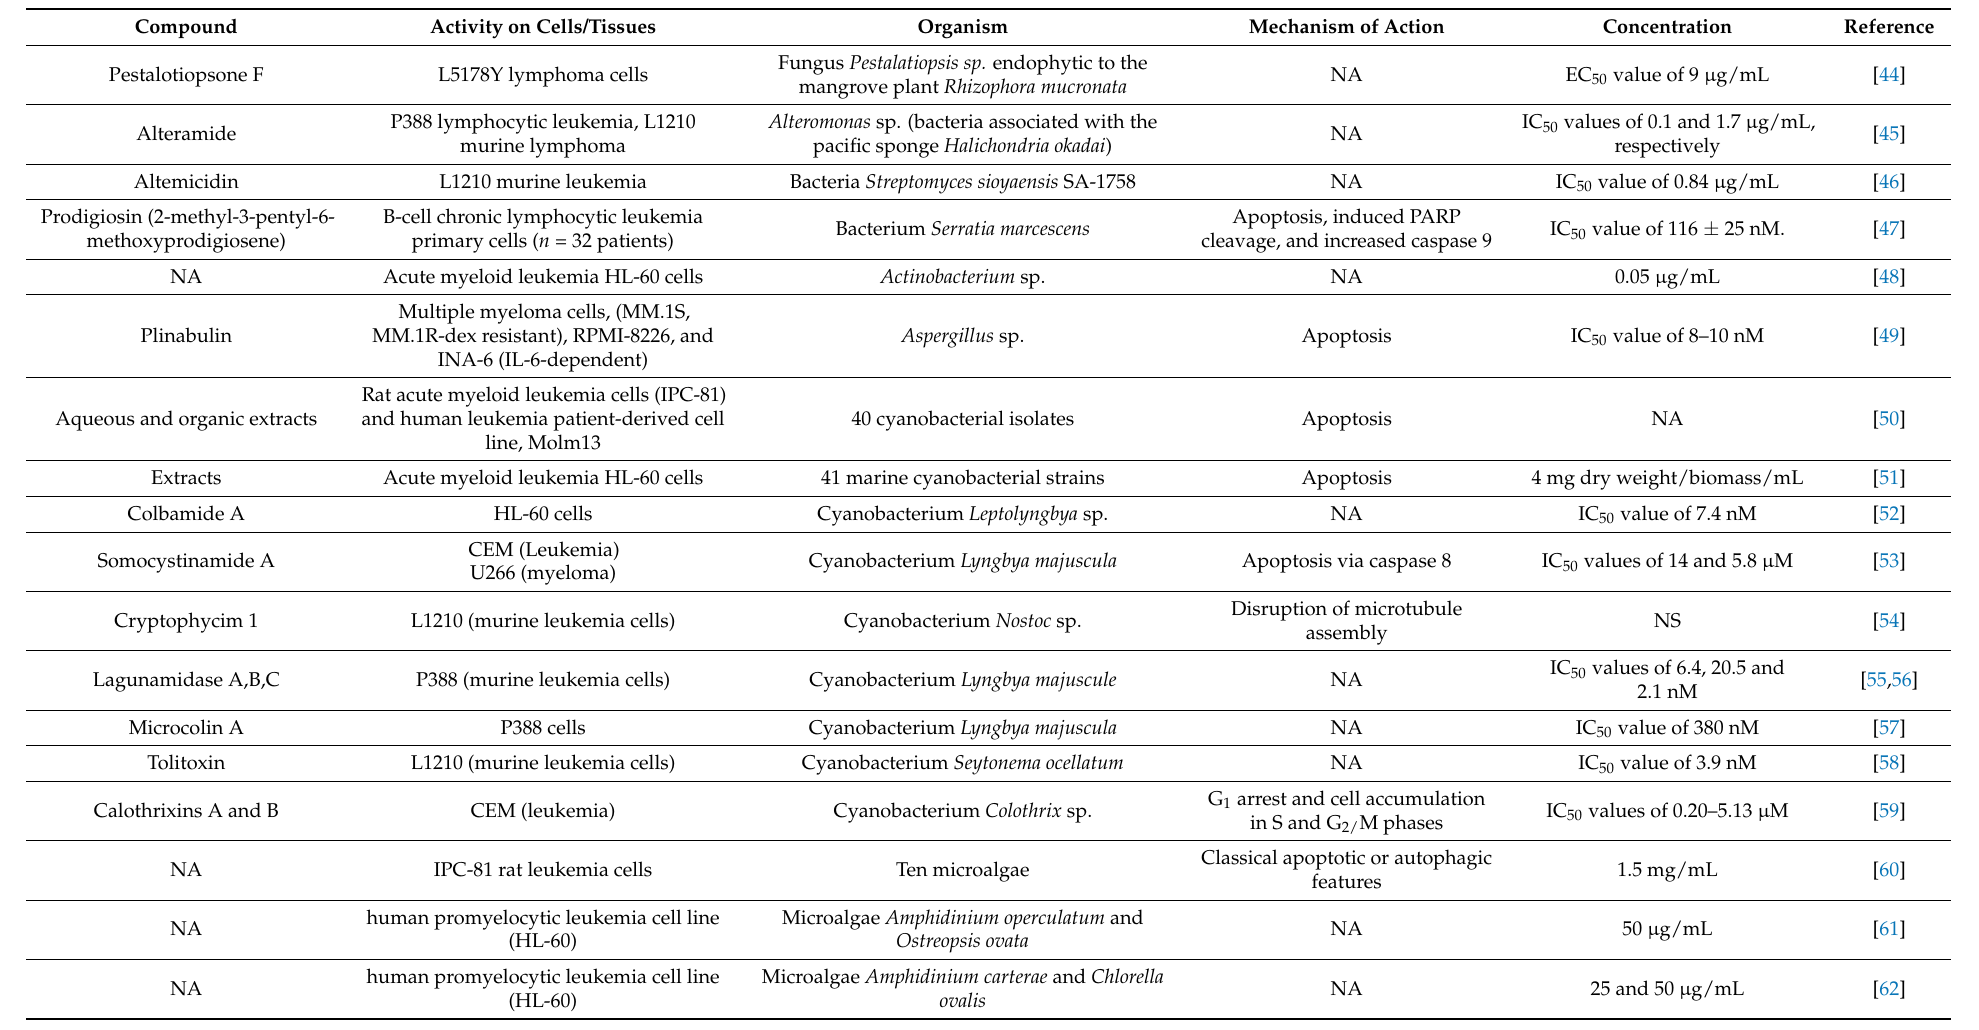
Table 3. Compounds/extracts from marine microorganisms active for hematopoietic tumors. NA, not